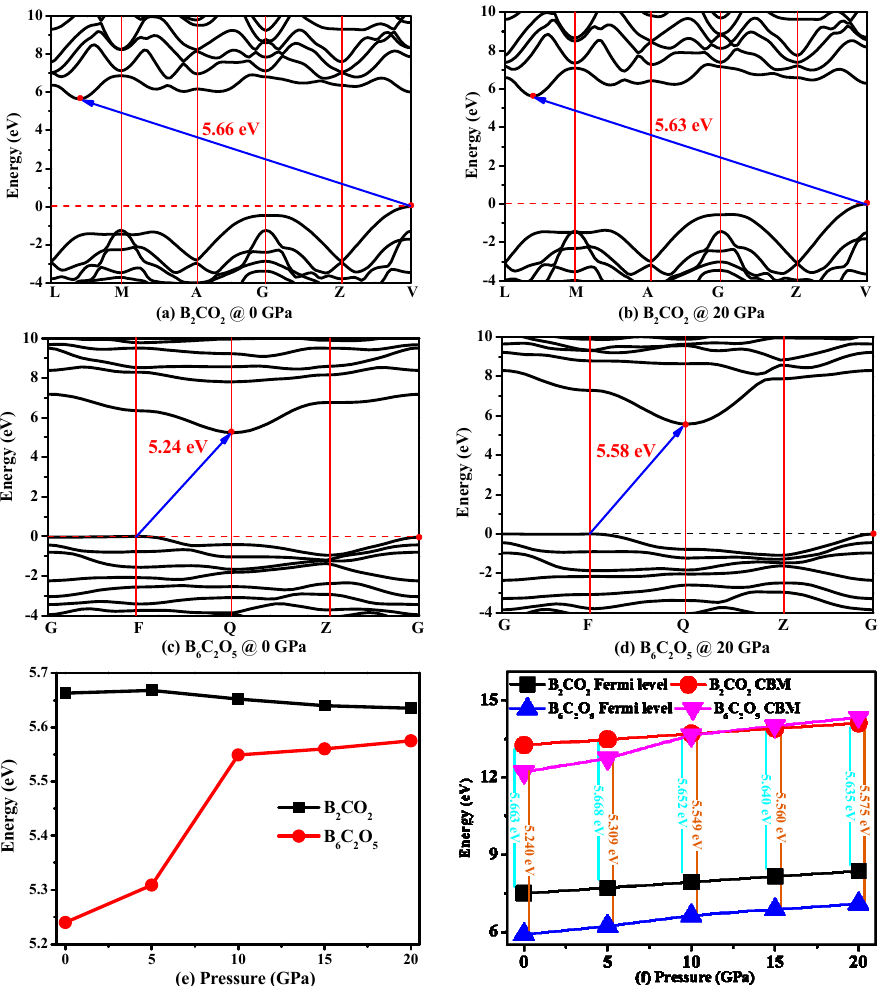
Figure 8. Band structures of: B 2 CO 2 (( a ): 0 GPa; and ( b ): 20 GPa); and B 6 C 2 O 5 ( c ): 0 GPa; and ( d ): 20 GPa); band gaps as functions of pressure for B 2 CO 2 and B 6 C 2 O 5 ( e ); and Fermi level and CBM as functions of pressure for B 2 CO 2 and B 6 C 2 O 5 ( f ).